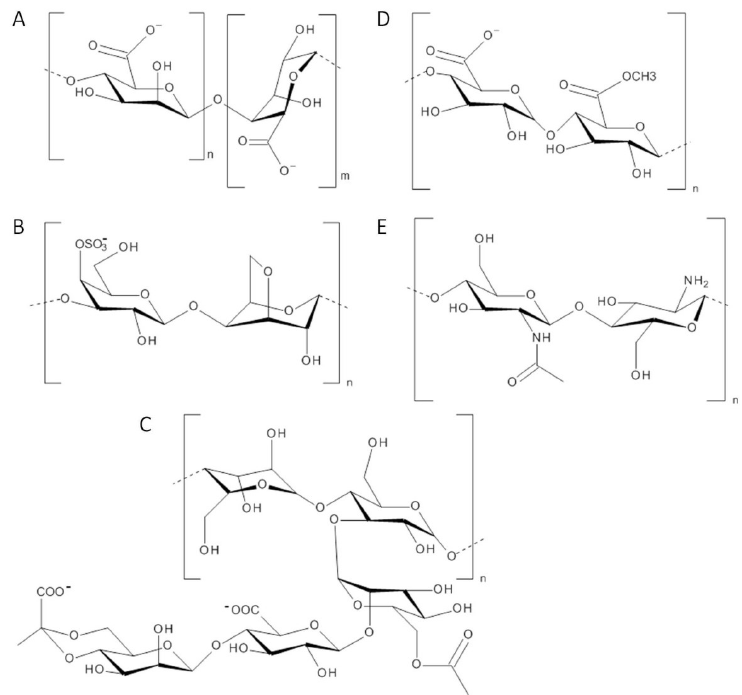
Figure 1. The chemical structures of: alginate ( A ); carrageenan ( B ); xanthan ( C ); pectin ( D ); and chitosan ( E